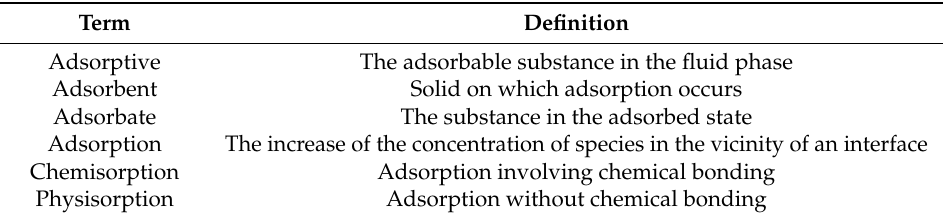
Table 1. Terms related to the adsorption